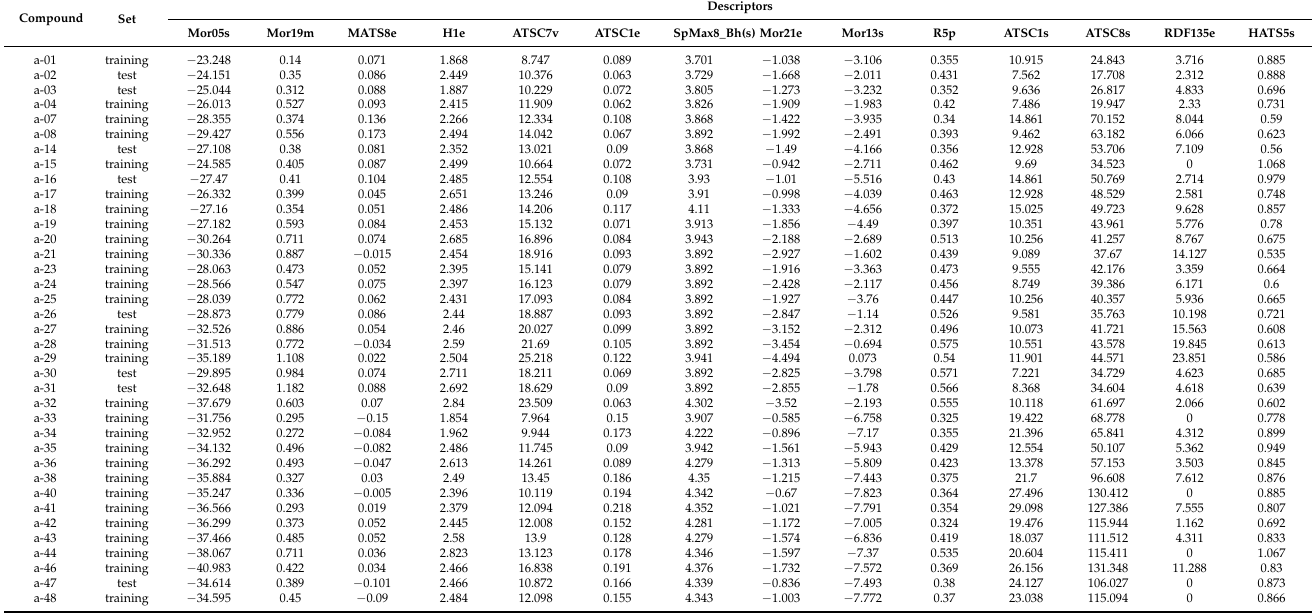
Table 1. Values of significant molecular descriptors for the tested anthrapyrazole derivatives.